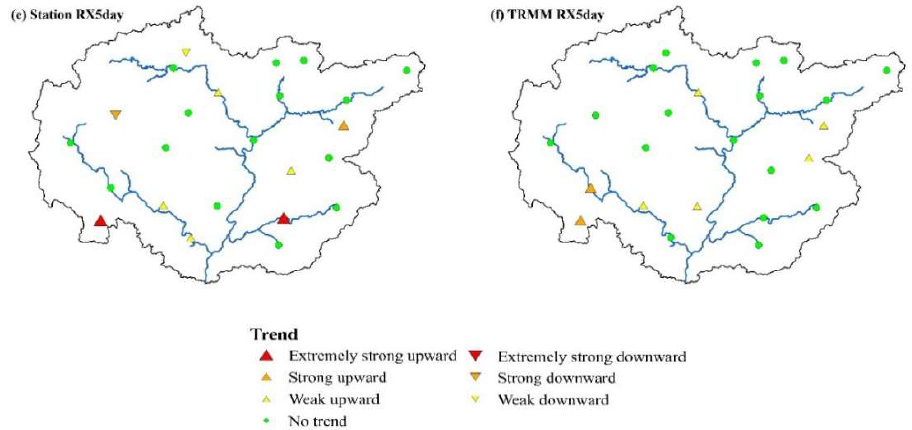
Figure 5. Spatial distribution maps of three consecutive extreme indices of the two datasets using the Cox–Stuart test.